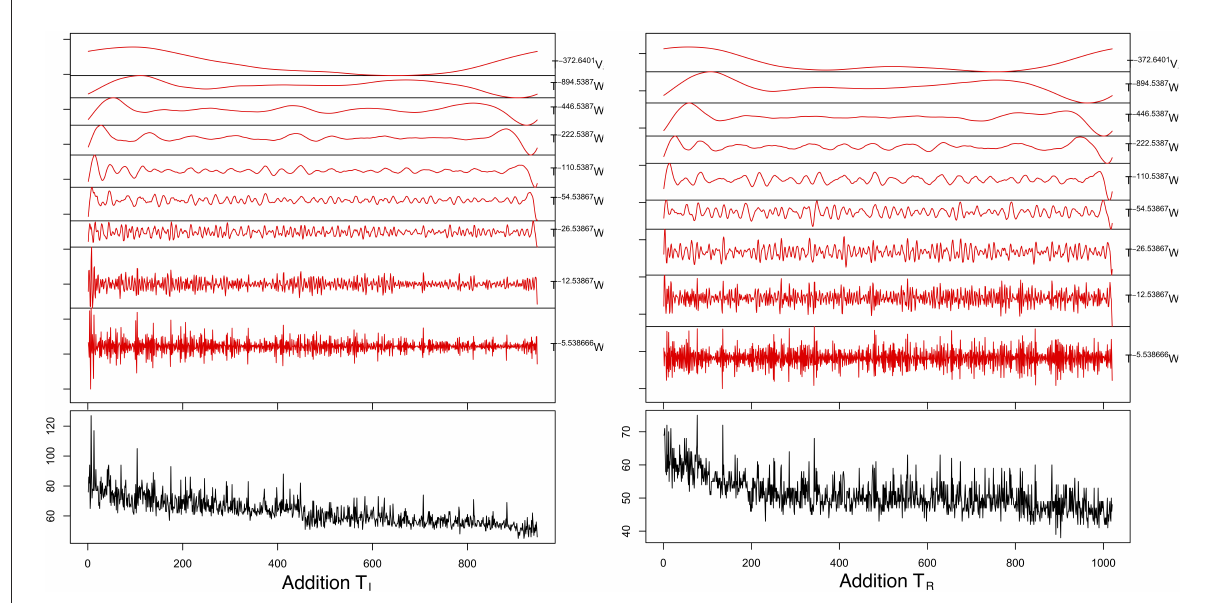
FIGURE7 Graphical representation of maximal overlap discrete wavelet transform (red plot) for the addition tasks (black plot). The decomposition was done using the using a d1-8 Daubechies wavelet, where W and V are the coefficient vectors that have been circularly advanced by the exponent in the shift operator